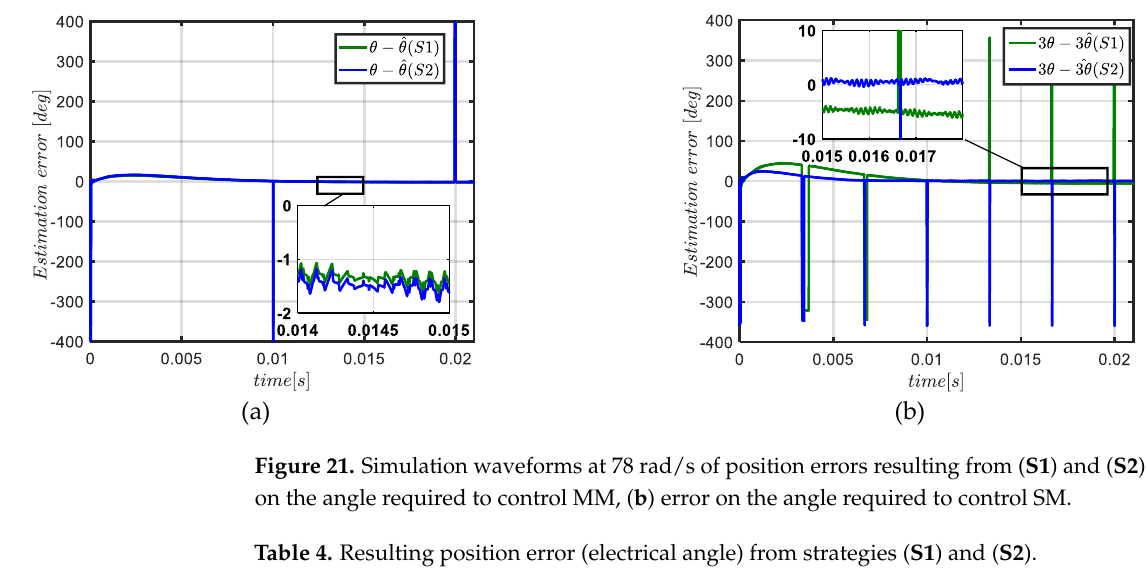
Figure 20. Simulation waveforms at 78 rad/s of actual and estimated rotor position with ( S1 ) and ( S2 ): ( a ) angle required to control MM, ( b ) angle required to control SM.